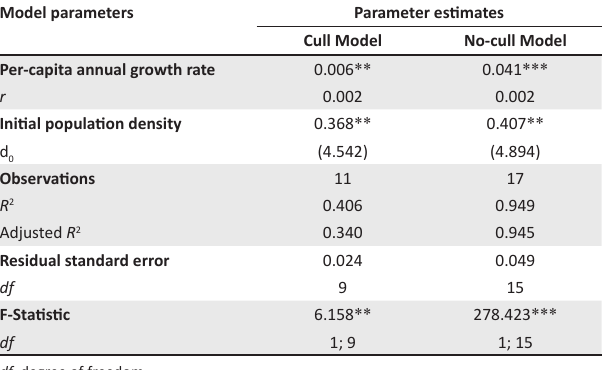
TABLE 1-A1: Exponential growth model parameter estimates and model statistics (Eqn 2).